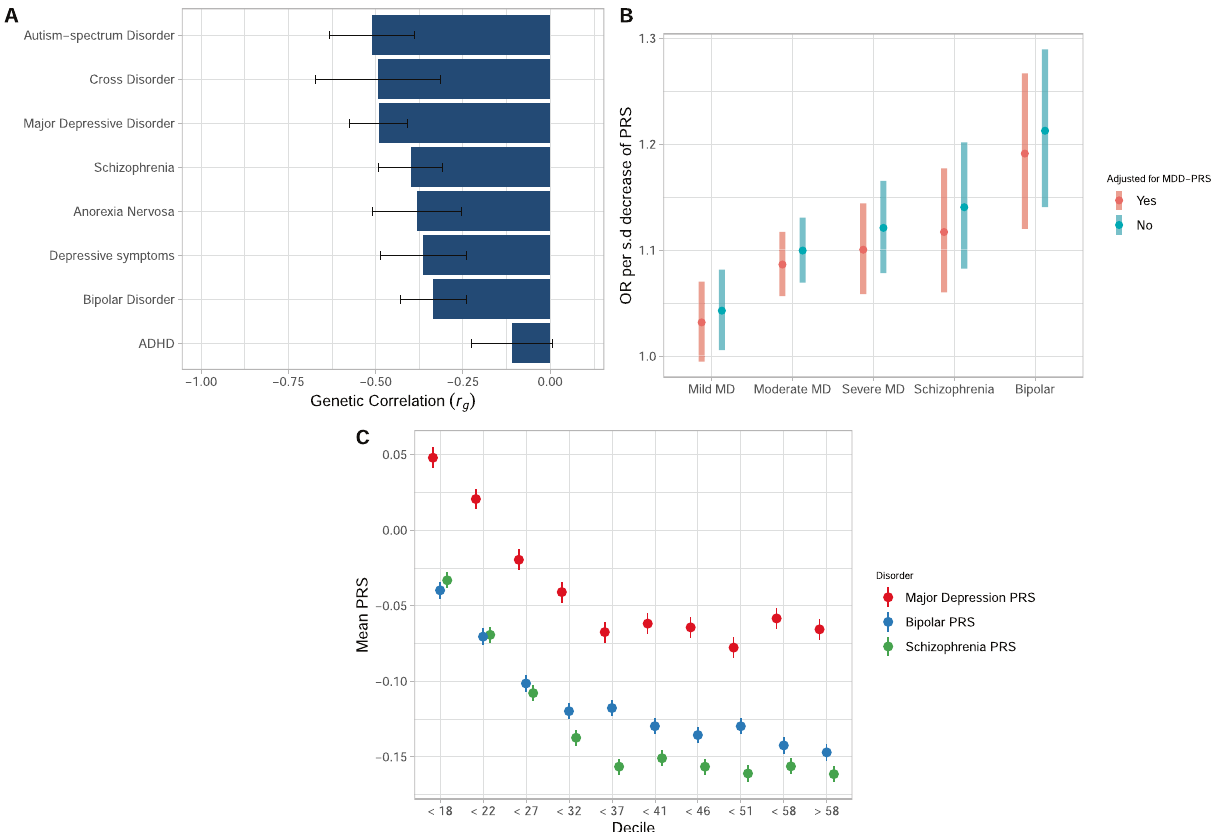
Fig. 2 Inverse relationship between AAO-MD and psychiatric disorders. A Genetic correlations ( r g ) estimated using High-De fi nition Likelihood between summary statistics from the meta-analyzed genome-wide association analysis on age at symptoms/diagnosis of major depression and psychiatric traits. The x-axis displays the r g estimate with error bars displaying the 95% con fi dence interval. The y-axis displays the psychiatric trait with which the genetic correlation was calculated. B The association between a polygenic risk score derived from genome-wide association analysis from AAO-MD and psychiatric disorders. The y-axis displays the odds ratios of psychiatric disorders per standard deviation decrease in PRS AAO-MD. The x -axis displays the psychiatric disorder. Error bars display the 95% con fi dence intervals. The odds ratio estimate is displayed with and without adjustment for MDD-PRS. C The mean PRS for major depression, schizophrenia, and bipolar disorder, strati fi ed by age at symptoms decile. The x -axis displays each decile for age at symptoms. The y-axis displays the mean PRS for each disorder within a decile. Error bars display 95% con fi dence interval of the mean PRS in each